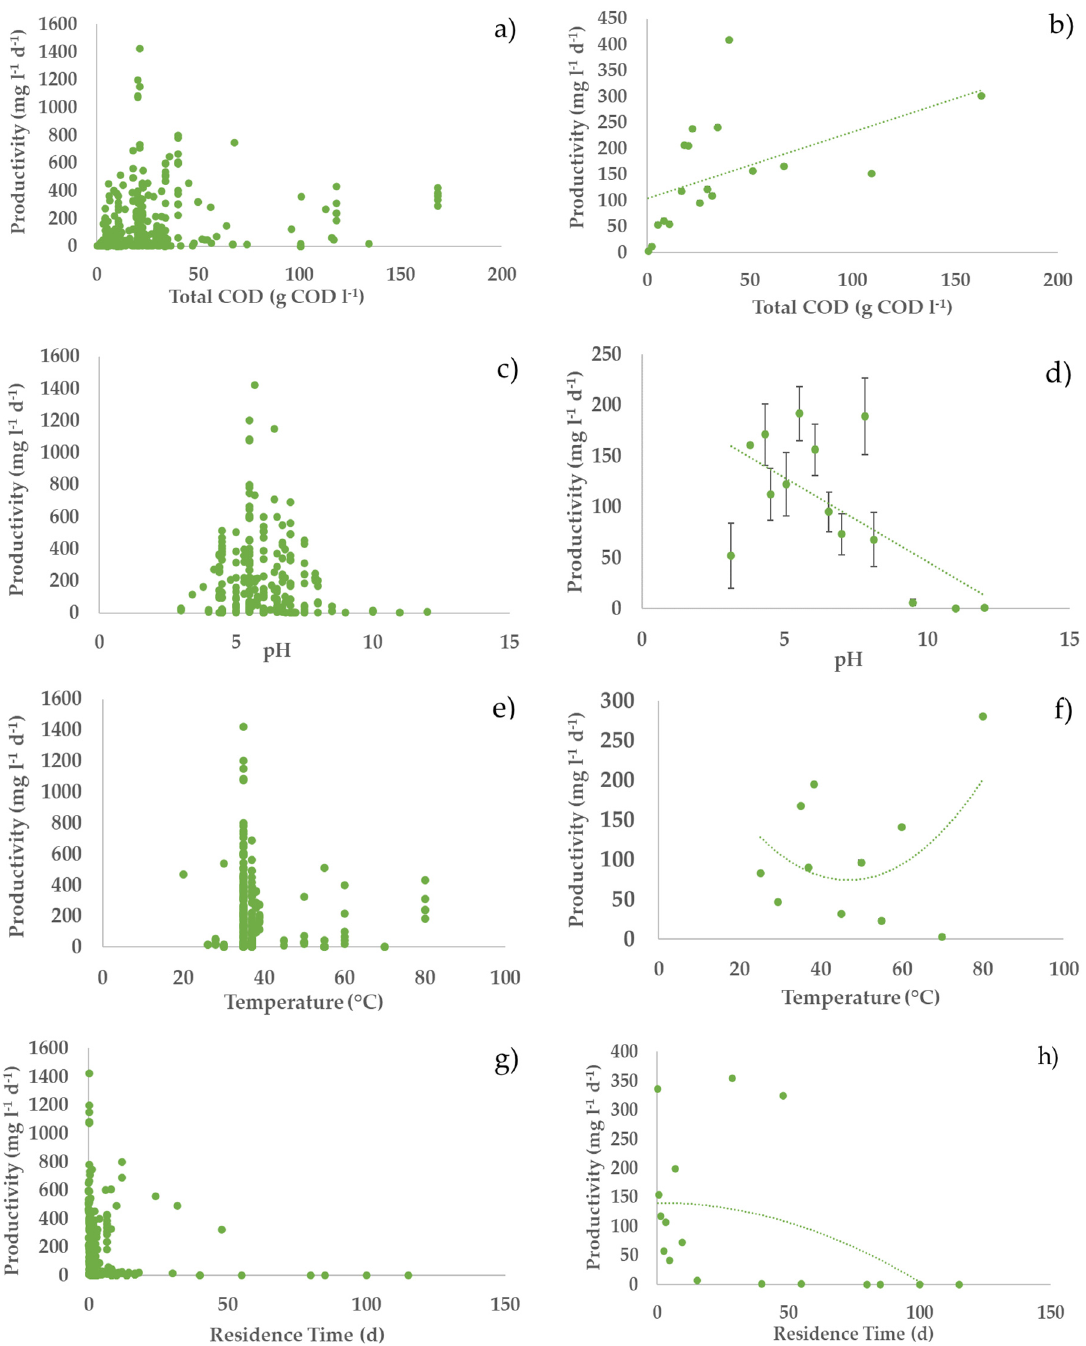
Figure 2. Relationships between hydrogen productivity and operational parameters: ( a , c , e , g ) all considered experiments; ( b , d , f , h ) average values of experiments in each narrow range (width maxi- mum 20%) of the operating parameters (error bars indicate the standard error) with second-order polynomial curve. The polynomial curve is only used to visualise the general trend, without any statistical significance.